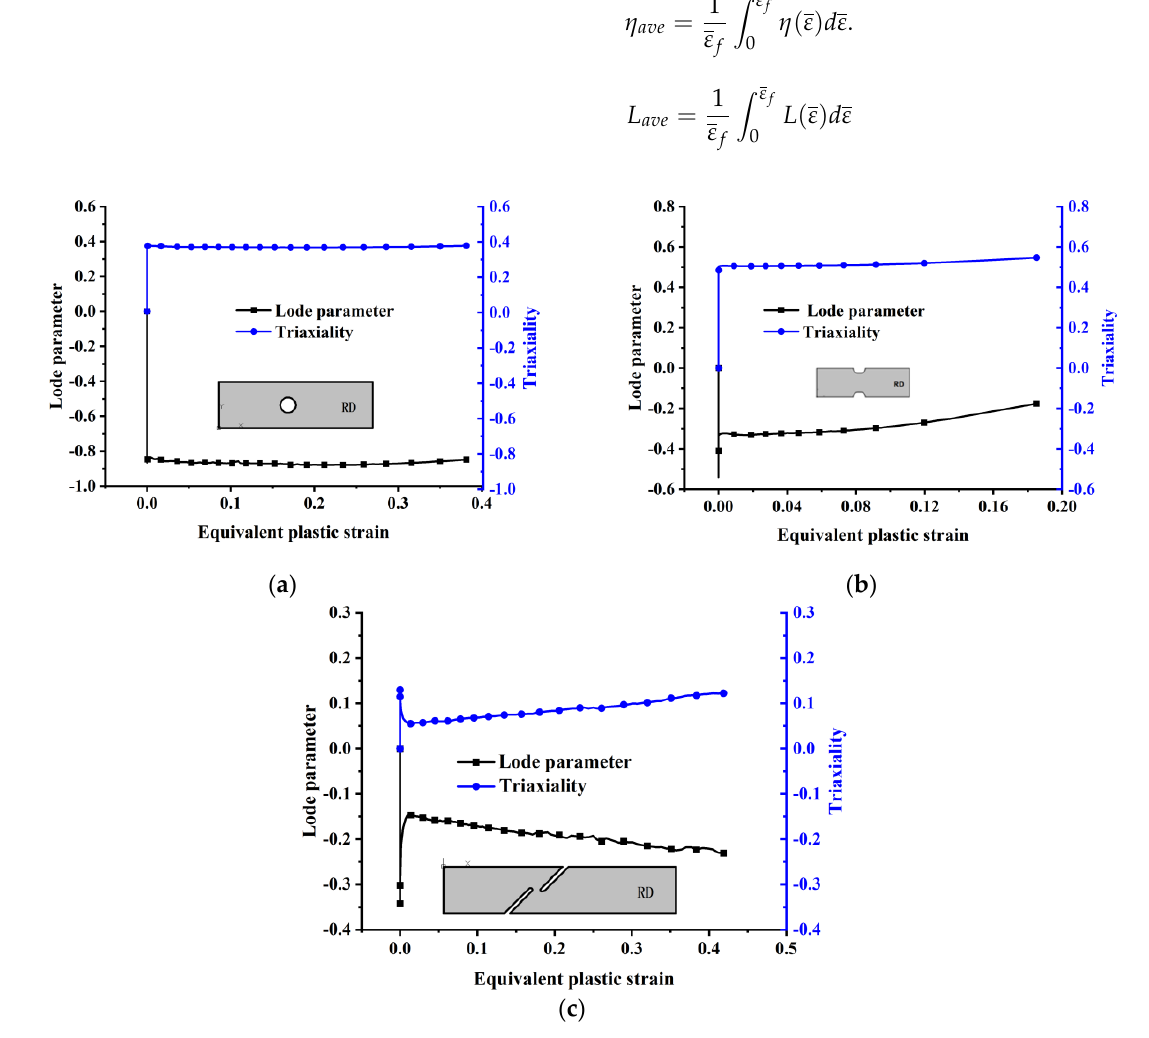
Figure 14. Evolution of stress triaxiality and Lode parameter with equivalent plastic strain: ( a ) specimen with a central hole; ( b ) notched specimen; ( c ) in-plane shear specimen.